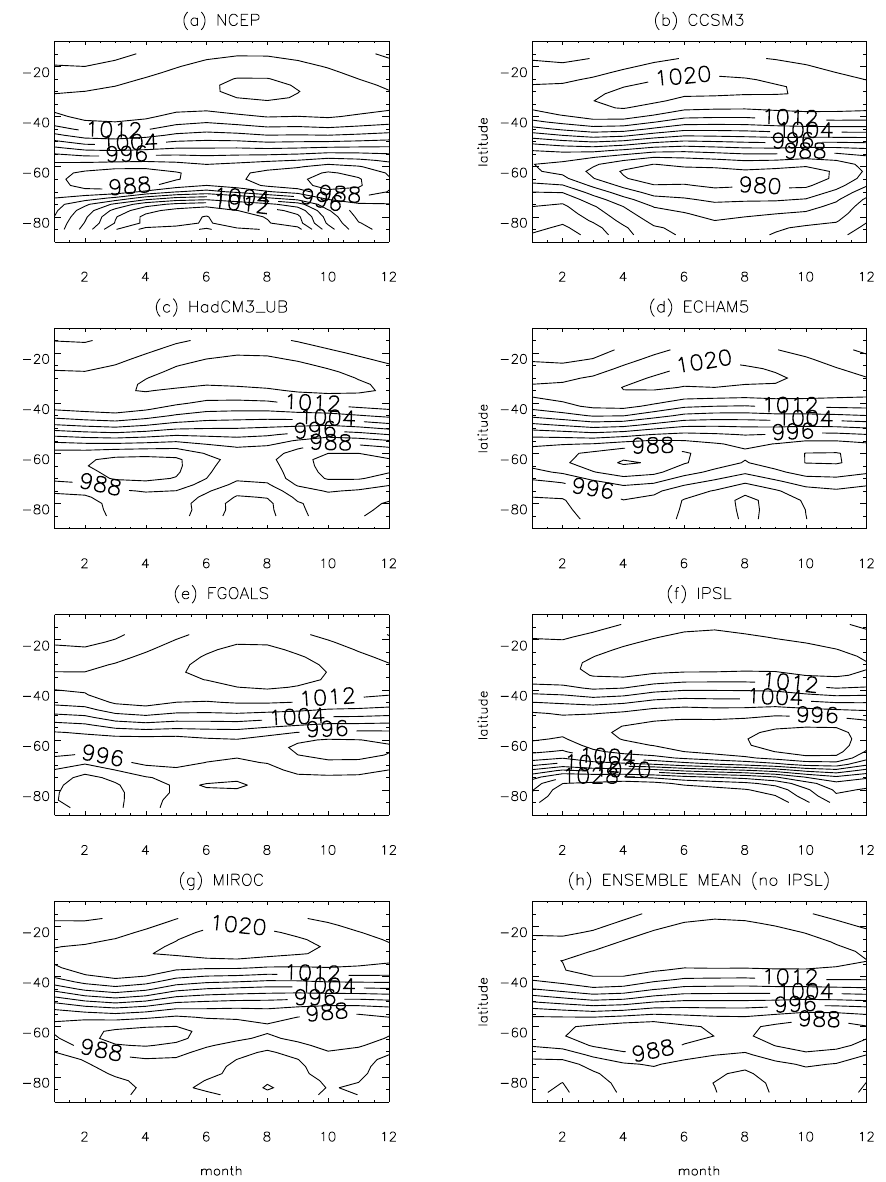
Fig. 4. Zonal mean sea level pressure (hPa) from re-analysis data and the PMIP2 control run for (a) NCEP (re-analysis), (b) CCSM3, (c) HadCM3 UB, (d) ECHAM5, (e) FGOALS, (f) IPSL, (g) MIROC and (h) the ensemble mean (without IPSL included) for each calendar month. Refer to Table 1 for details of each